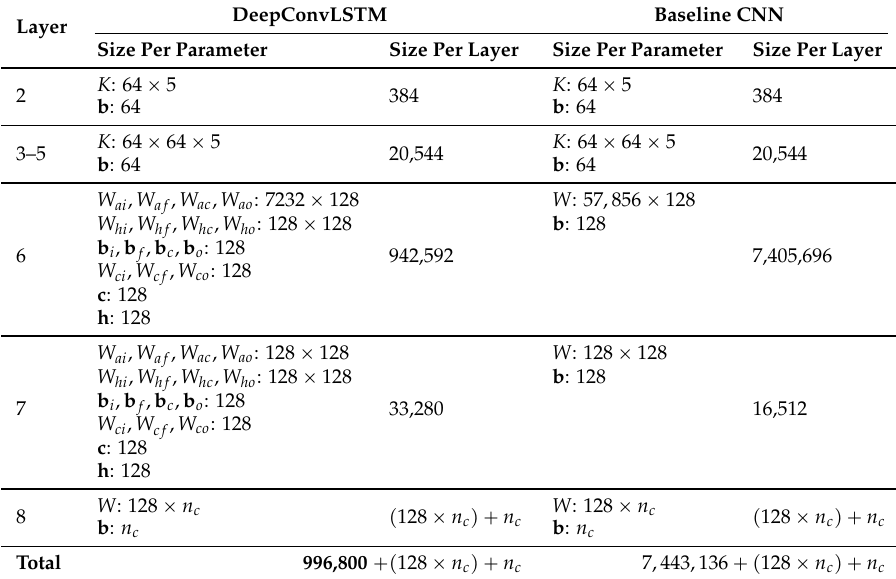
Table 1. Number and size of parameters for the DeepConvLSTM architecture and for the baseline model. The final number of parameters depends on the number of classes in the classification task, denoted as n c .